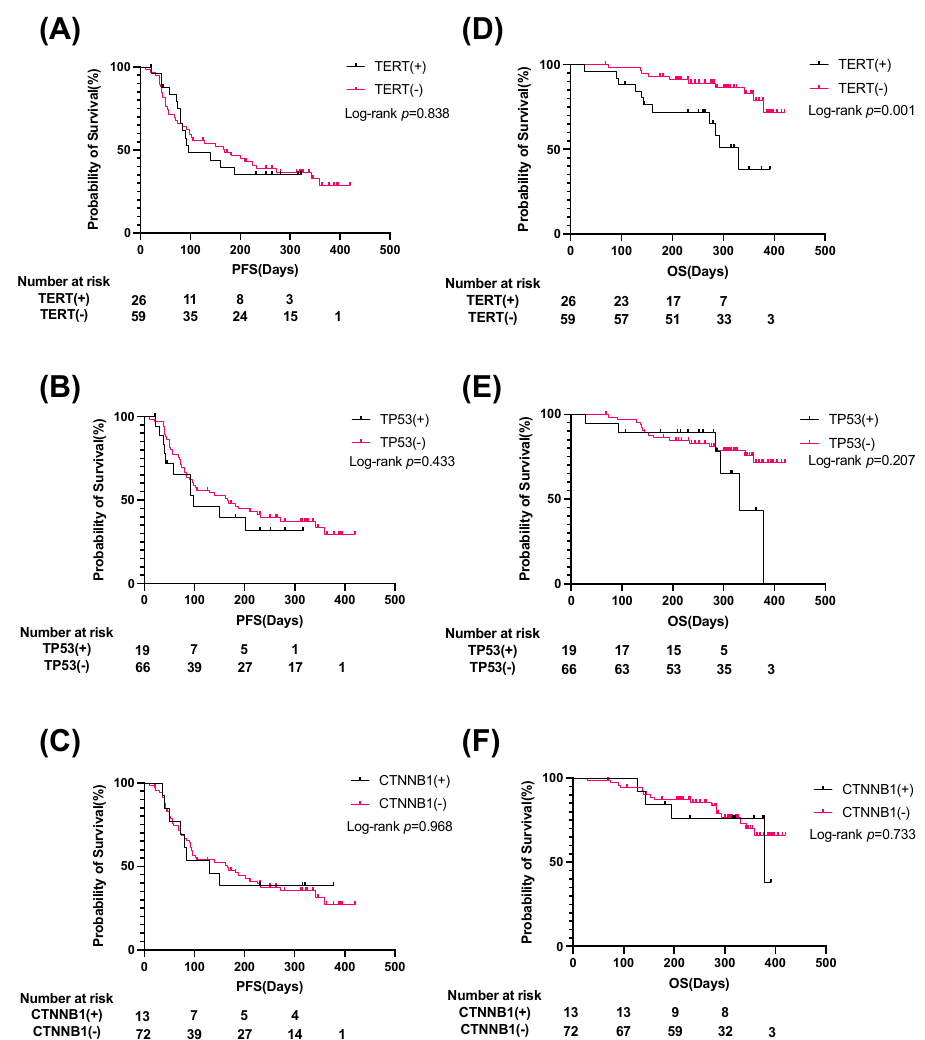
Figure 4. Patients with TERT promoter ctDNA have significantly shorter OS than those without. Total 85 u-HCC patients treated with Atezo/Bev were classified into two groups according to the presence or absence of specific ctDNA mutations including TERT ( A , D ), TP53 ( B , E ), CTNNB1 ( C , F ) . The Kaplan–Meier curves of progression-free survival (PFS) ( A – C ) and overall survival (OS) ( D – F ) for each group. ctDNA, circulating tumor DNA; u-HCC, unresectable hepatocellular carcinoma; Atezo/Bev, Atezolizumab and bevacizumab.